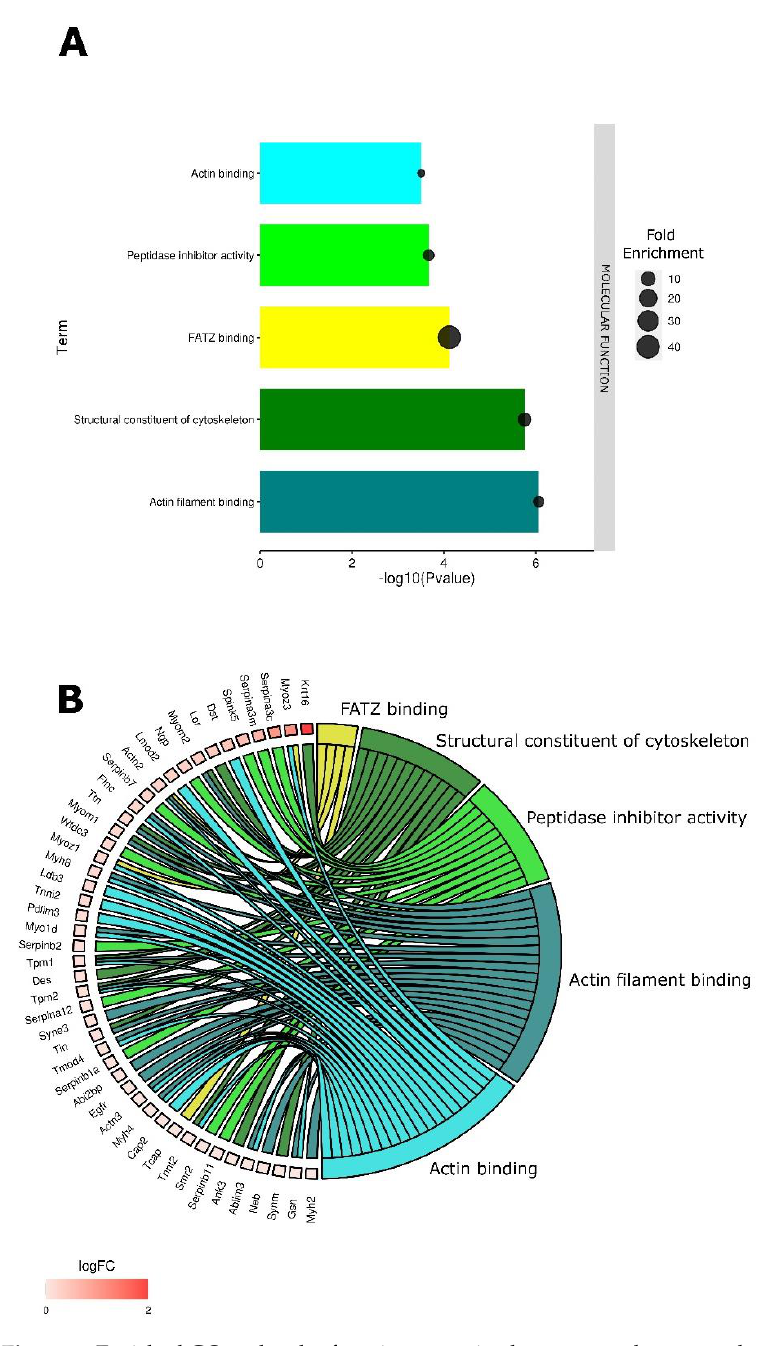
Figure 1. Enriched GO molecular function terms in electroporated tumors when compared to controls. ( A ) The bar dot plot shows the GO molecular function terms plotted in order of significance. ( B ) The chord plot shows the overlap of the DEGs contributing to these terms arranged in order of their fold change.